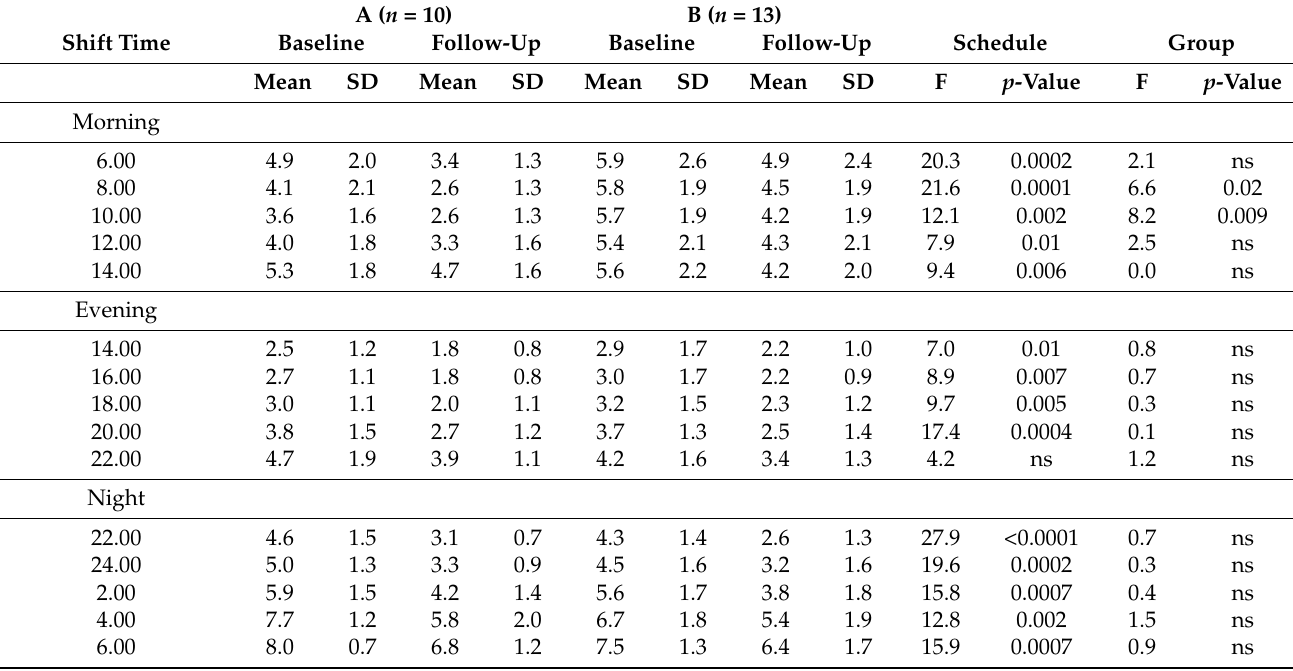
Table 3. Effects of schedule change and trial group on the shift-specific retrospective alertness (KSS, average, SD) as a dependent variable during every second hour of work shifts at the baseline and at the